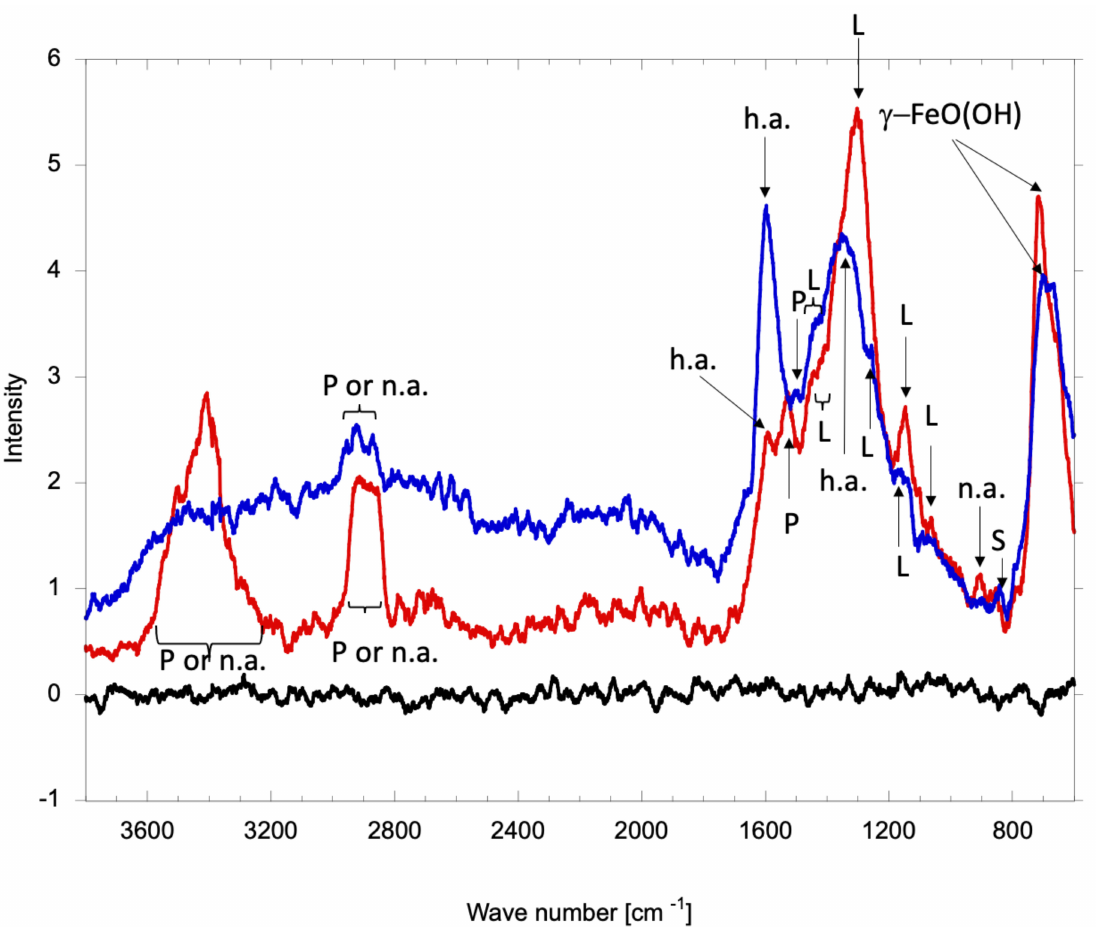
Figure 3. Raman spectra of the surface of pure iron pieces. The black, red, and blue lines indicate the Raman spectra for iron piece prior to the tests, after LBR test, and after slowly rotating TTC test, respectively. P: proteins; n.a.: nucleic acids; h.a.: humic-like acids; L: lipids; and S: